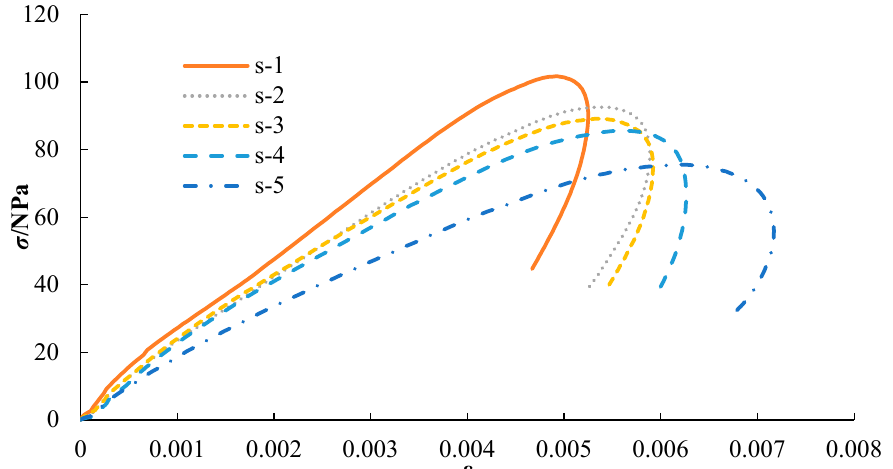
Figure 4. Stress ‐ strain curves of saturated samples. Figure 4. Stress-strain curves of saturated samples.